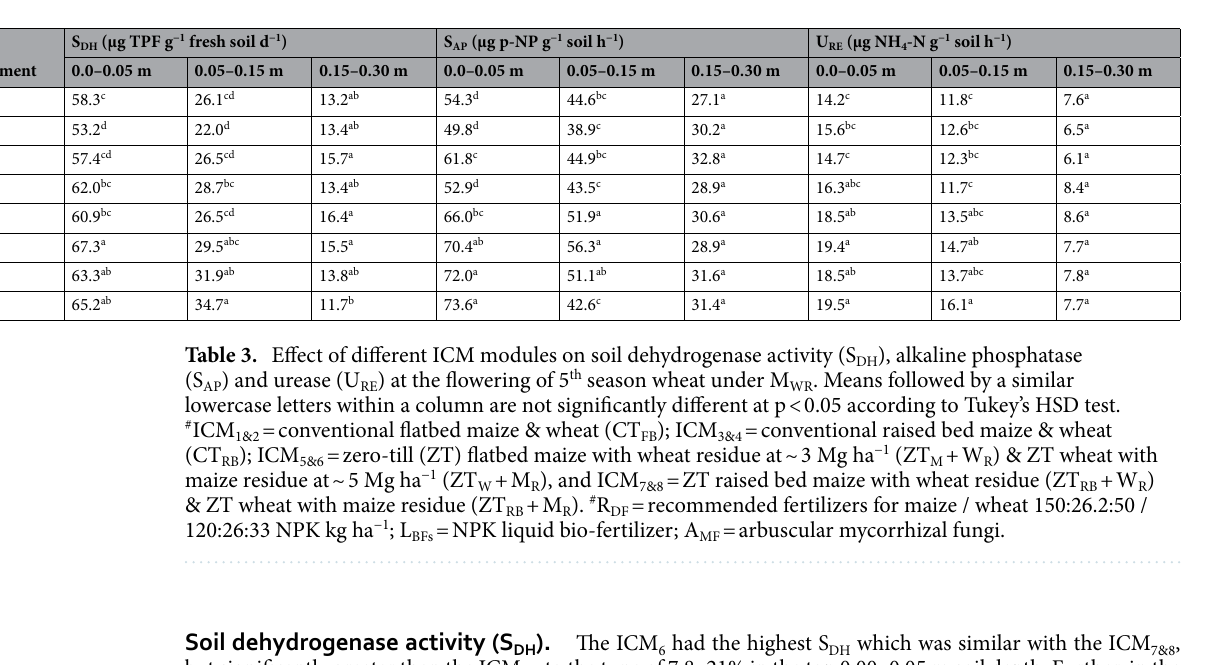
Figure 4. Effect of ICM modules on S OC ( a ) and soil microbial biomass carbon (S MBC ) ( b ) at different soil depths at flowering of 5th season wheat in the maize-wheat rotation. Means followed by a similar lowercase letter within a bar are not significantly different at p < 0.05 using Tukey’s HSD test.